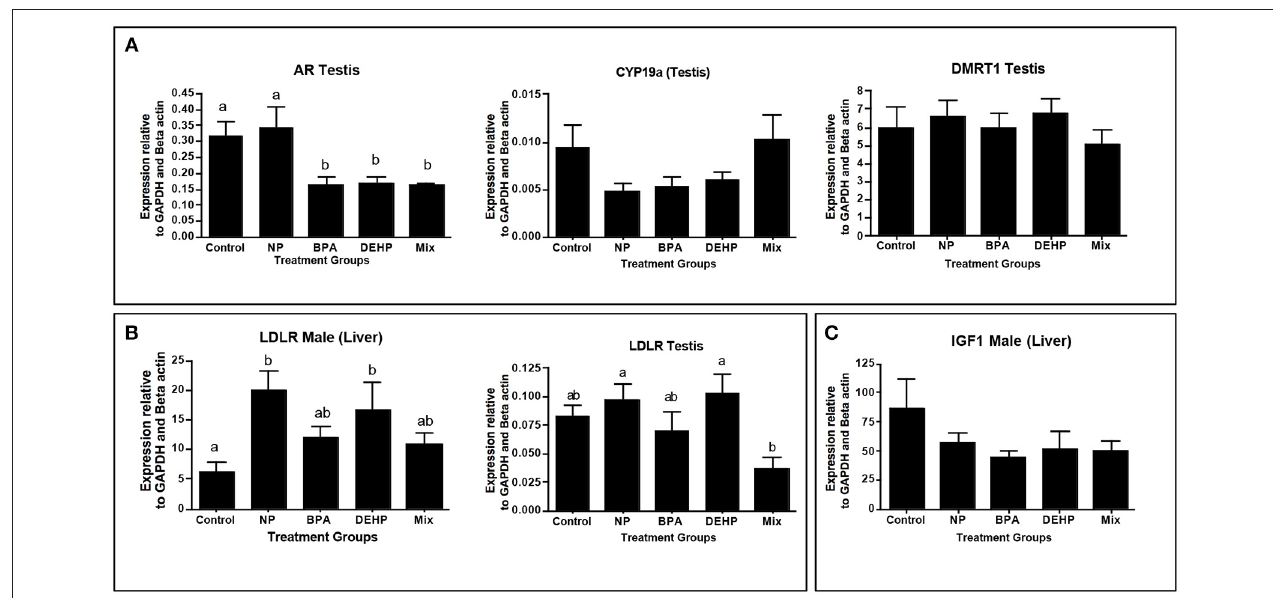
FIGURE 5 | Confirmation of top regulators predicted by ingenuity pathway analysis (IPA) software, using quantitative real-time PCR (qPCR). Top regulators were predicted based on significantly regulated genes relative to control in microarray analysis. Genes were selected based of their function in the altered pathways: Androgen signaling (A) , PPAR/RXR Activation (B) and IGF1 signaling (C) . The expression levels were measured using qPCR and normalized against the mean of GAPDH and β -actin (mean ± SEM). Different letters indicate a significant difference (ANOVA followed by Tukey Test, P < 0.05, n = 12).